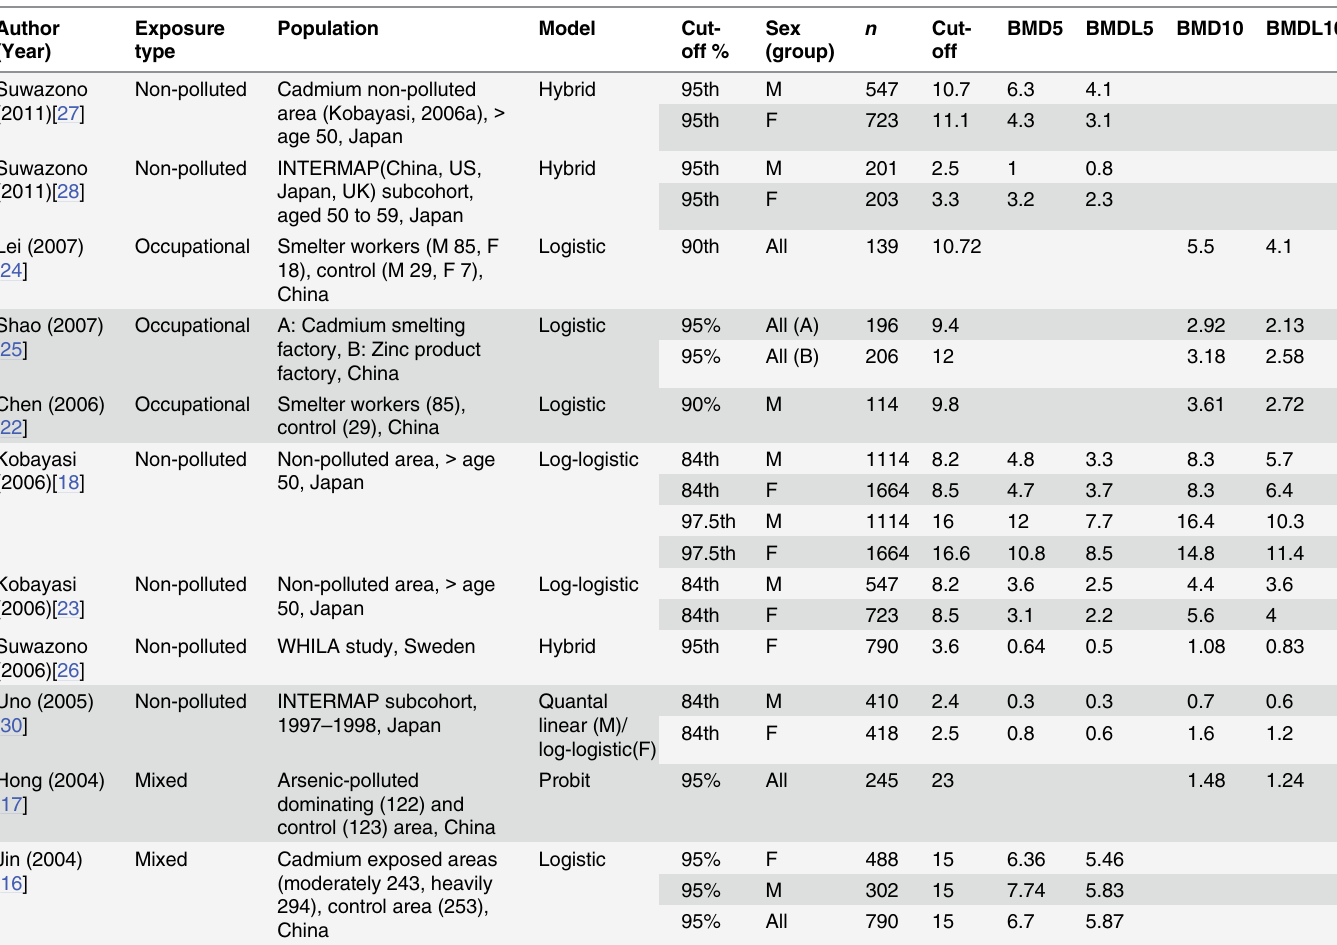
Table 2. Studies reporting benchmark dose for cadmium-induced